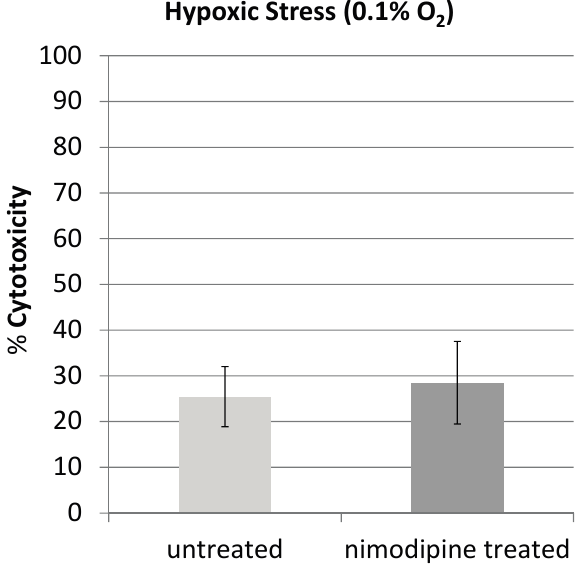
Figure 4. PC12 cells were cultivated under 0.1% O 2 for 3 h to induce hypoxic stress. No significant difference in the cytotoxicity between nimodipine-treated (25.4%) and untreated (28.5%) PC12 cells could be